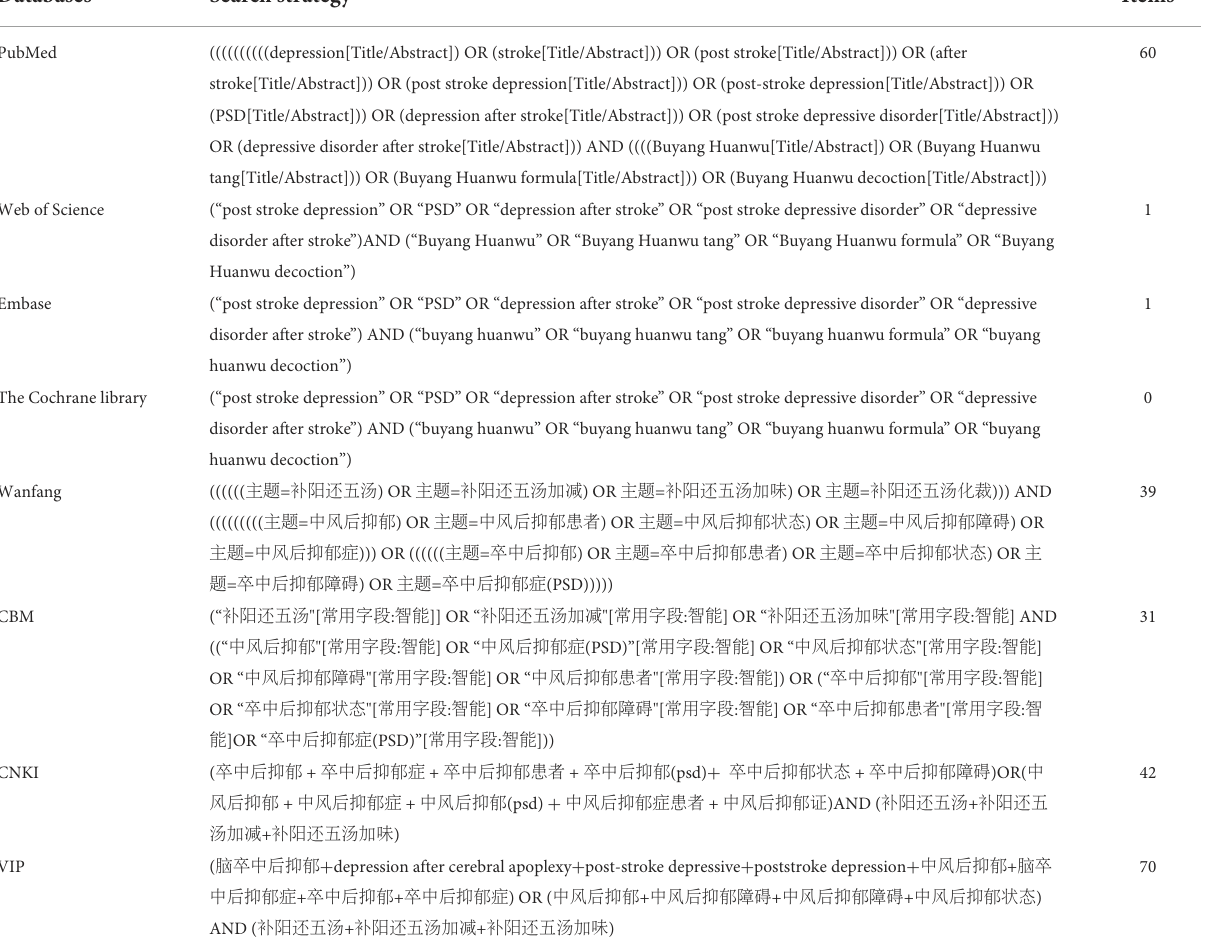
TABLE 1 Search strategy to identify RCTs in